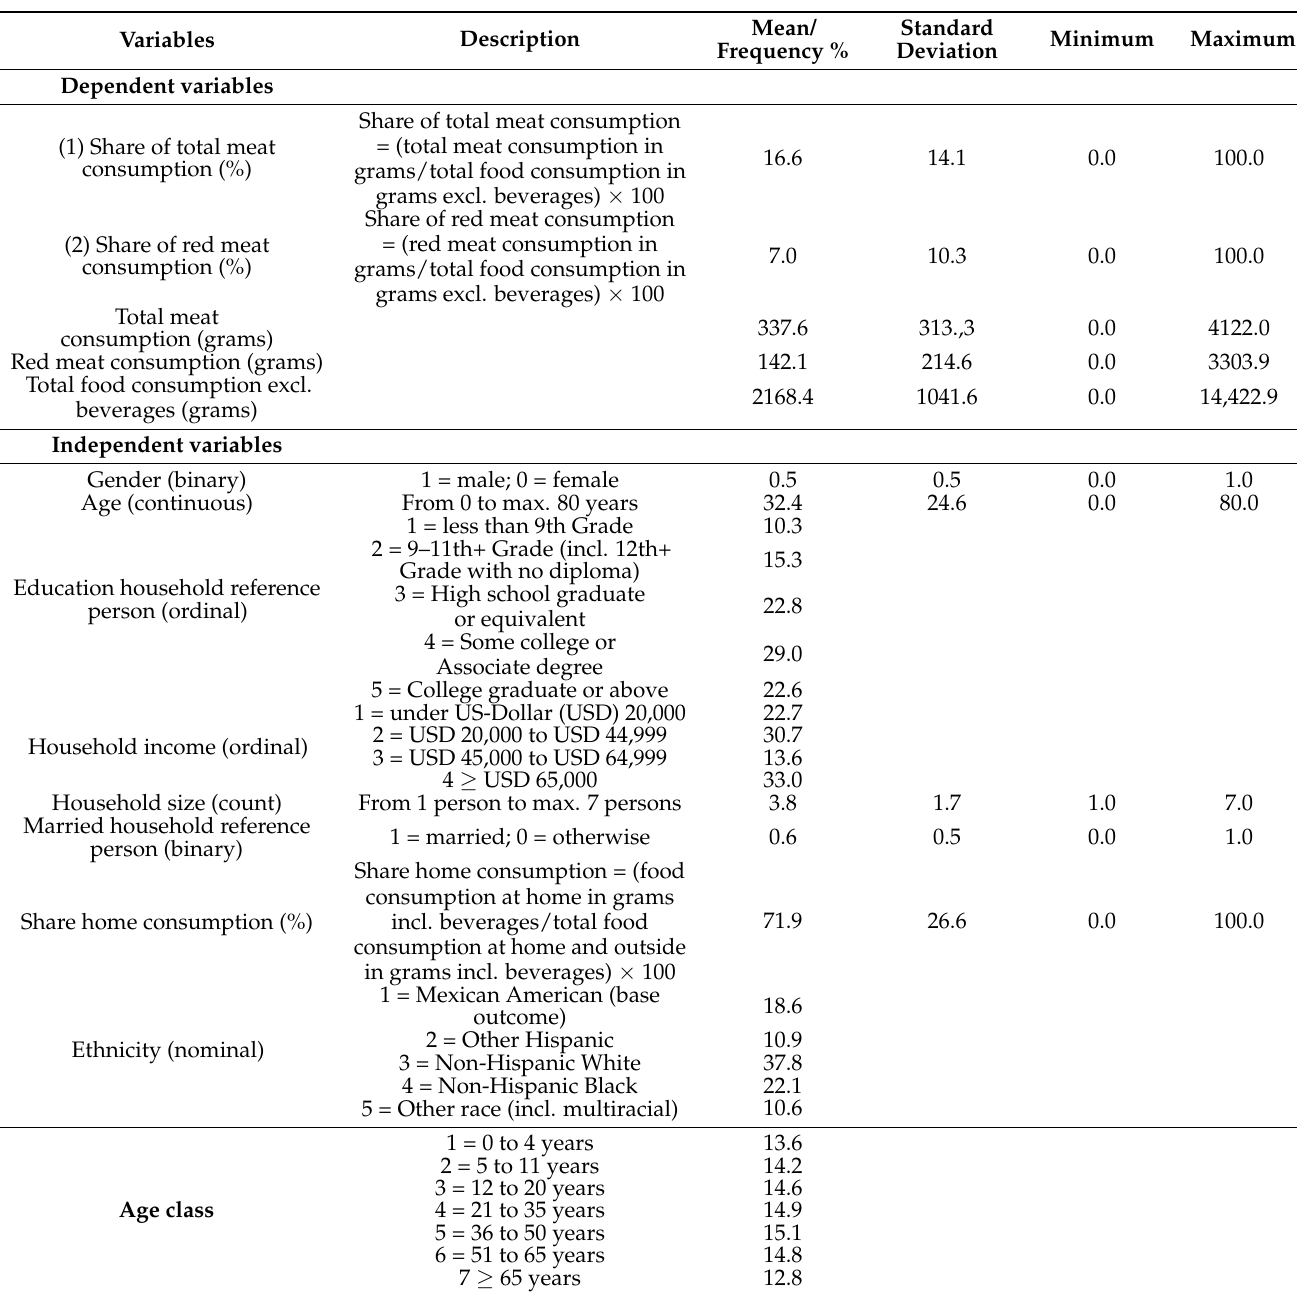
Table 2. Description and summary statistics of the